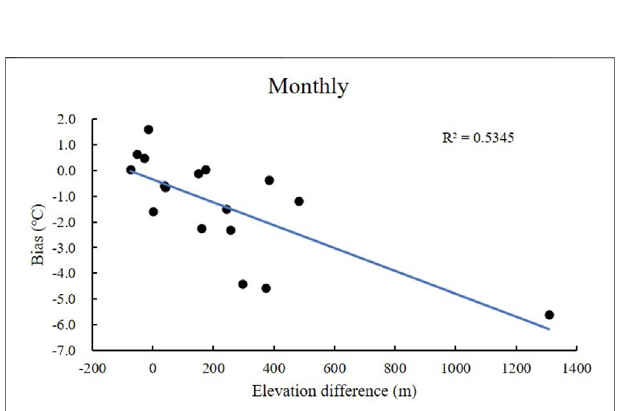
FIGURE 8 | Relationship of bias and elevation differences between annual observations and ERA5-Land during the 1979 – 2017 period.